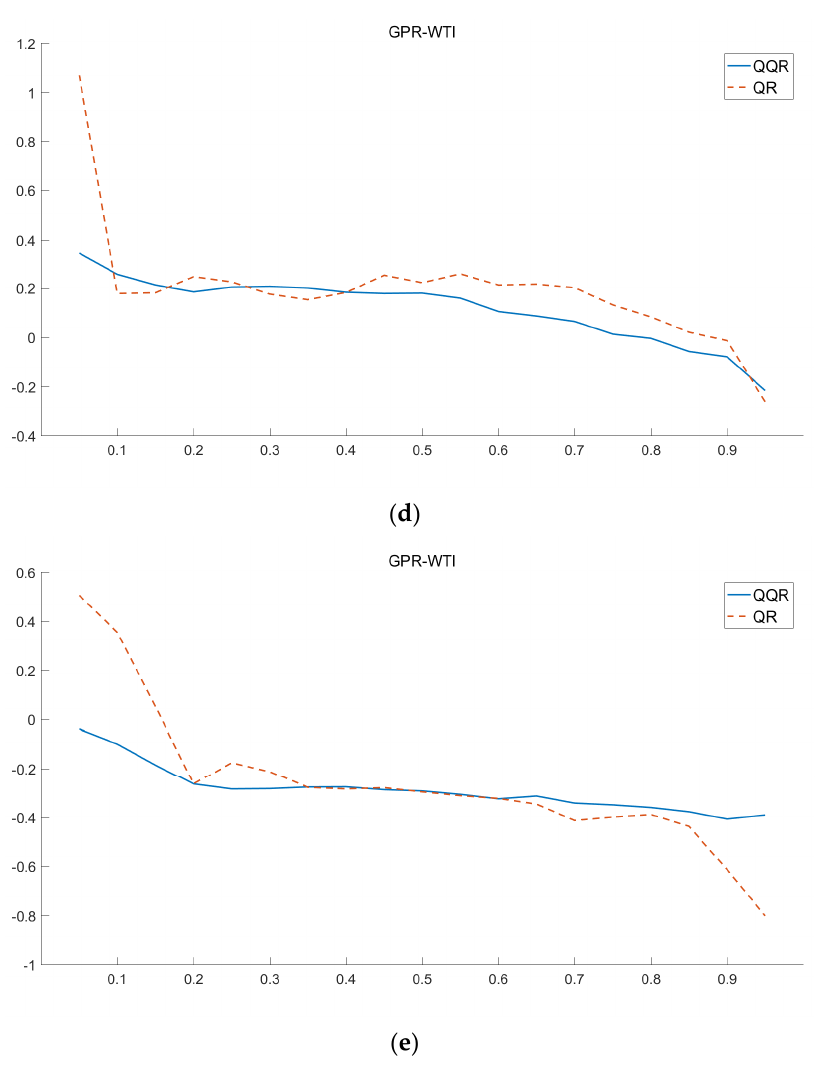
Figure 7. Comparison of impact coefficient estimates of the GPR on the WTI under QQR and Q.R. ( a ) Comparison of the impact of GPR on WTI under the Q.R. and the QQR at D1; ( b ) Comparison of the impact of GPR on WTI under the Q.R. and the QQR at D2; ( c ) Comparison of the impact of GPR on WTI under the Q.R. and the QQR at D3; ( d ) Comparison of the impact of GPR on WTI under the Q.R. and the QQR at D4; ( e ) Comparison of the impact of GPR on WTI under the Q.R. and the QQR at D5.